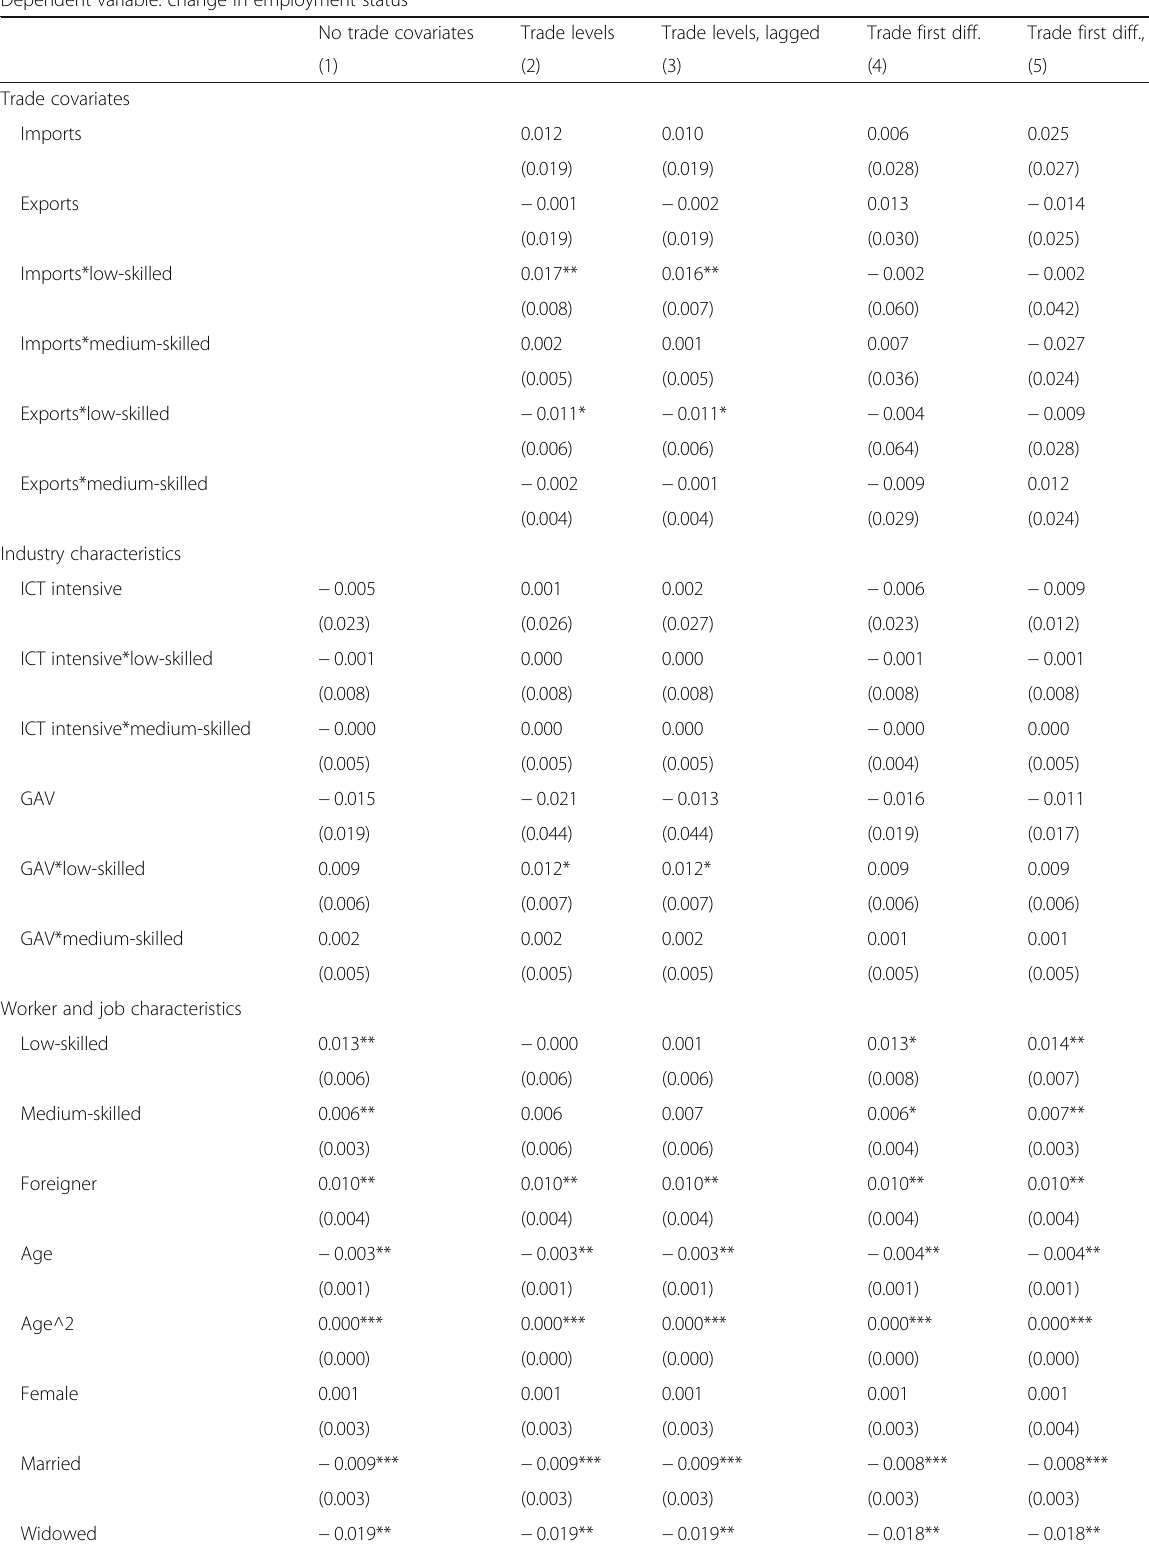
Table 2 Linear regressions of changes in employment status on trade variables and individual